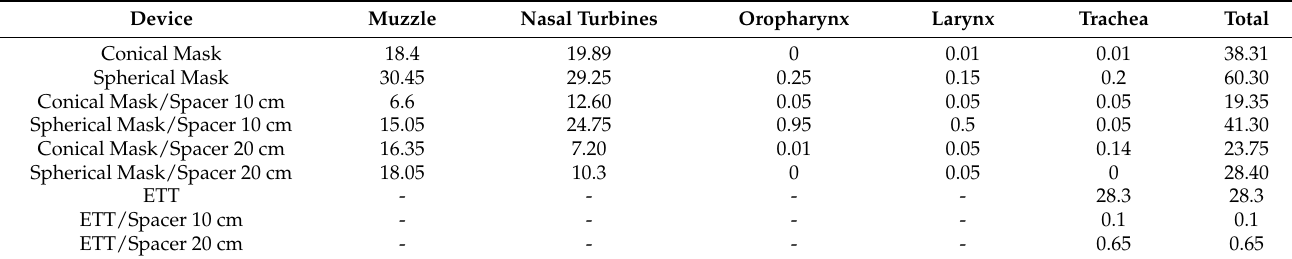
Table 4. Percentage of particles deposited to the different areas of the upper airways. Device